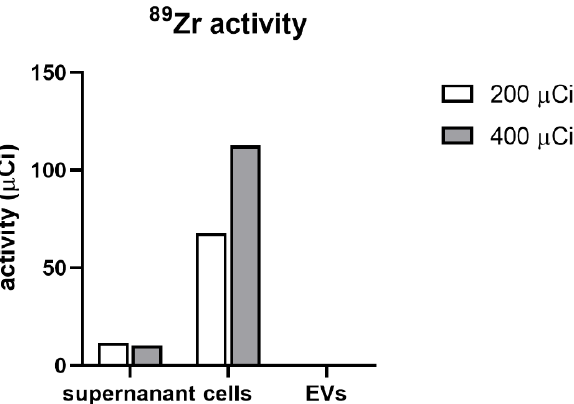
Figure 6. The activity of 89 Zr in the supernatant, cells and isolated EVs.